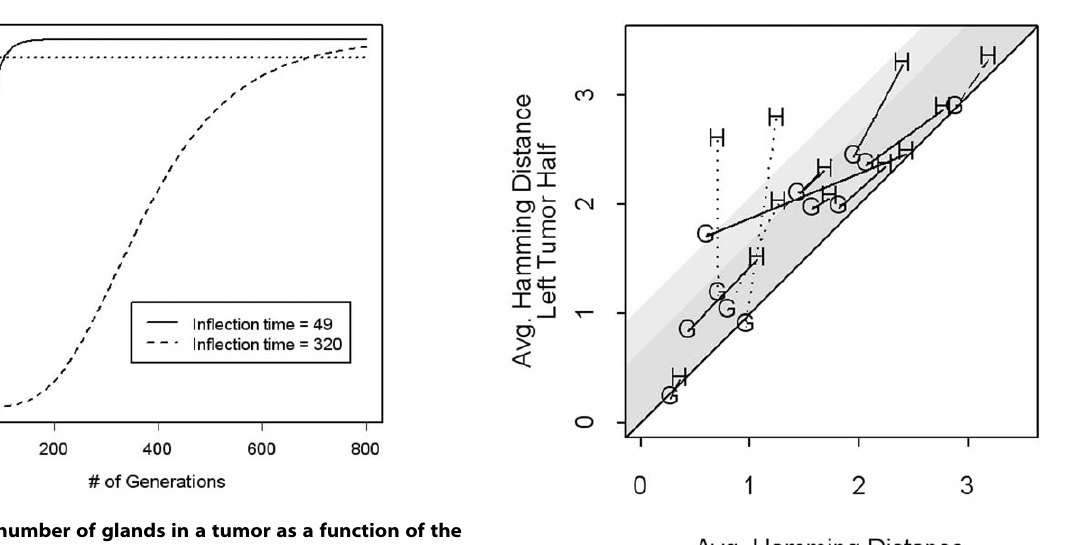
Figure 3. The number of glands in a tumor as a function of the number of generations of cell division for Gompertzian growth models with inflection times of 49 and 320 generations and a maximum of 524,288 glands.